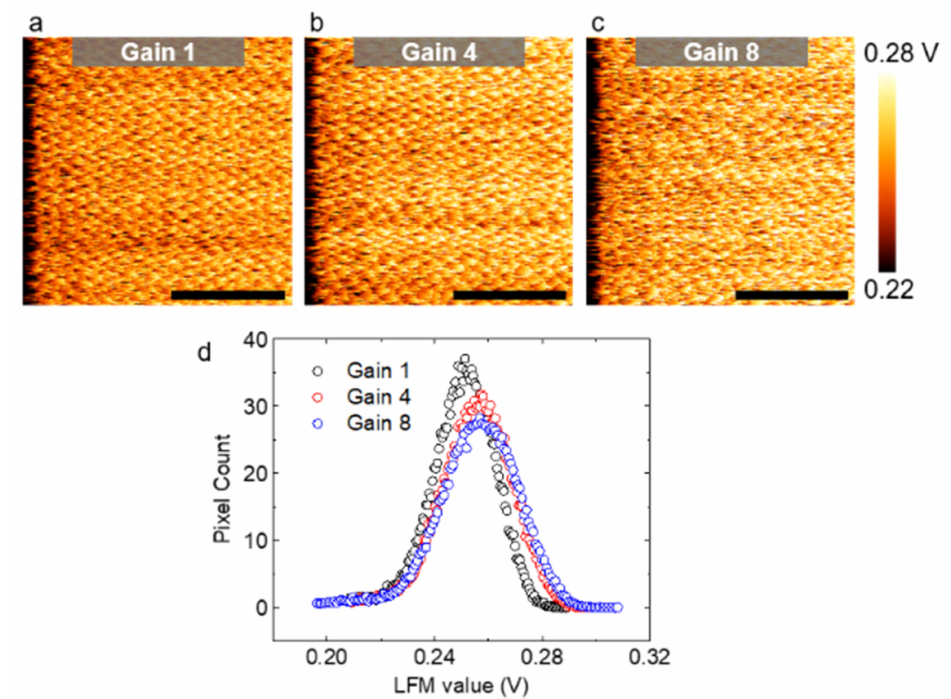
Figure 5. The effect of the gain on atomic-level LFM images (color range adjusted). ( a – c ) LFM images of multilayer graphene acquired at various gain values and at a scan rate of 19 Hz. The lattice structure became more difficult to identify, as the gain value increased. All scale bars are calibrated and represent 2 nm; ( d ) number of pixels by the LFM value for different gains. The vertical axis indicates how many pixels in an image belong to a certain LFM value. As the gain increased, the LFM data values were more spread out from the